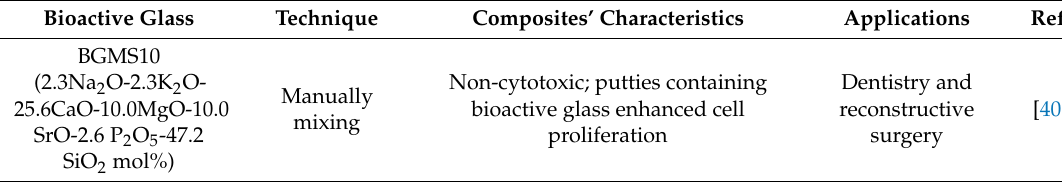
Table 1. Summary of collagen / bioactive glass composites for various biomedical